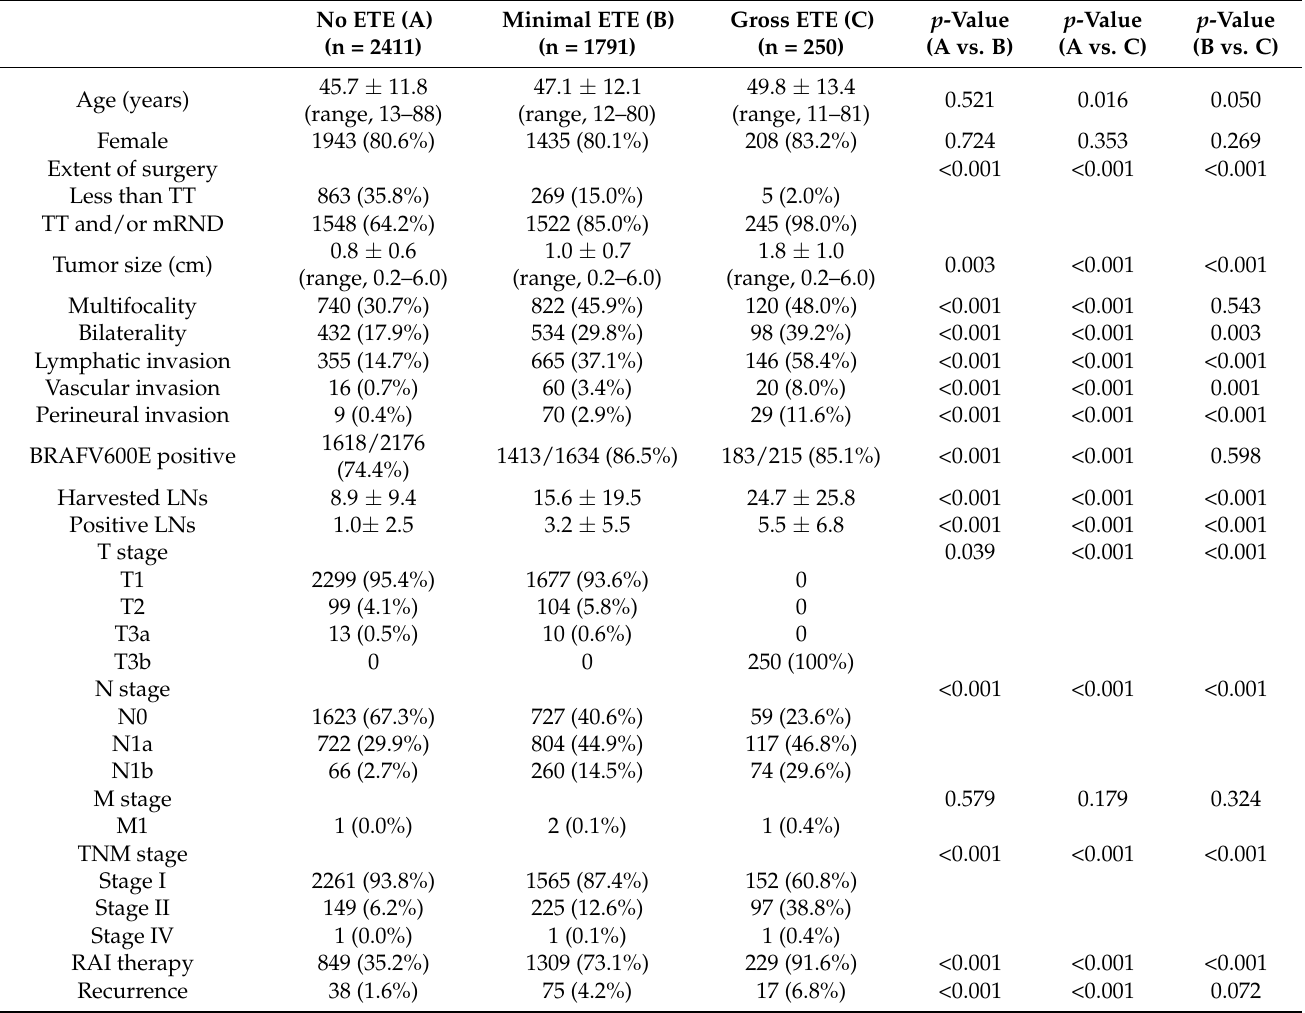
Table 1. Comparison of clinicopathological characteristics according to the ETE status before propen- sity score